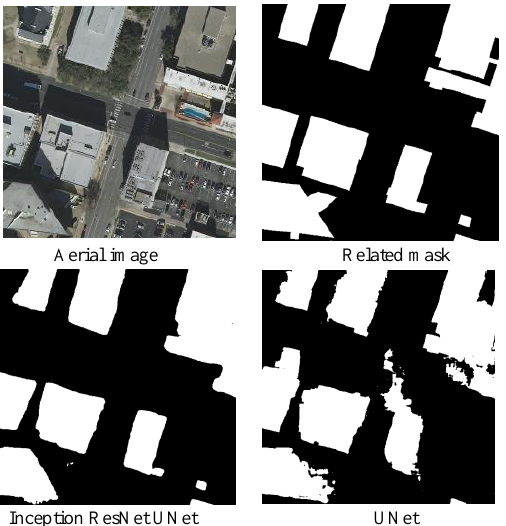
Figure 9. Tall buildings in Inception ResNet UNet are detected more precisely in comparison with UNet. This model detects some shadows as part of the